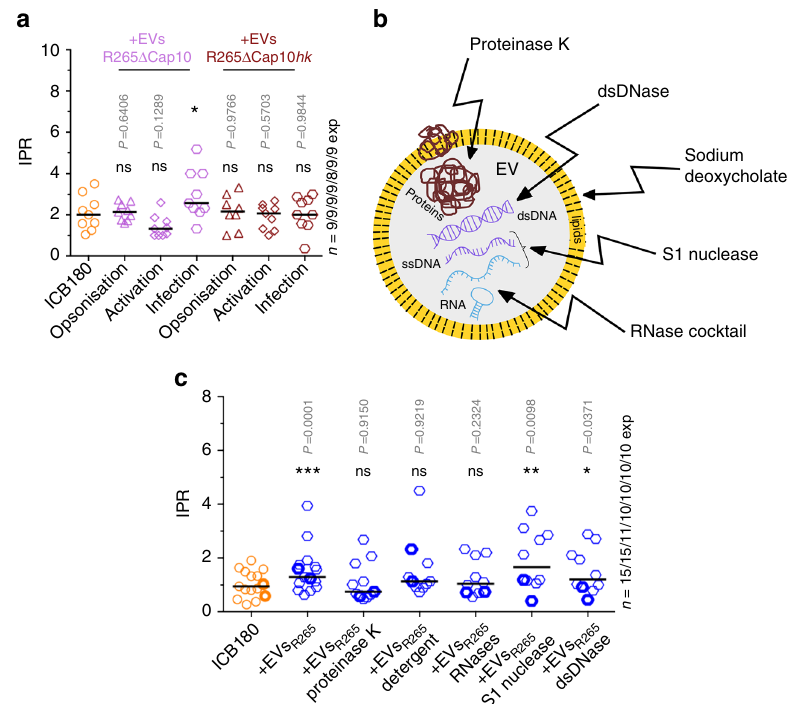
Fig. 4 EV proteins and RNA are necessary to increase survival of cryptococci inside macrophages. a IPRs of ICB180 growing alone (ICB180) and in the presence of 10 μ g of EVs isolated from acapsular strain R265 Δ Cap10 (EVs R265 Δ Cap10 ) or heat-inactivated EVs R265 Δ Cap10 (EVs R265 Δ Cap10 hk ) added at different stages of infection: during yeast opsonisation using PHS (opsonisation), J774 activation (activation) or during incubation with both macrophages and ICB180 yeast cells (infection; see also Fig. 3a). Data are presented as scattered dot plots with lines representing their medians. Data are representative of results from 8 to 9 independent experiments with 147 – 301 total number of yeasts counted for each sample. Wilcoxon paired t test where * ( P = 0.0117), signi fi cant difference; and ns ( P > 0.05), not signi fi cantly different. b Schematic drawing of the EV and treatments performed towards protein degradation via proteinase K, lipids degradation via sodium deoxycholate, double-stranded DNA (dsDNA) degradation via dsDNase, single-stranded DNA (ssDNA) and single-stranded regions of RNA degradation via S1 nuclease and further RNA degradation, including RNA duplexes, via RNase cocktail of RNase A and T1. c IPR values of ICB180 are increased in the presence of 10 μ g of EVs (or 50 μ g — symbols with thicker borders) isolated from R265 ( + EVs R265 ), EVs R265 treated with S1 nuclease ( + EVs R265 S1 nuclease) and EVs R265 treated with dsDNase ( + EVs R265 dsDNase) but not when EVs treated with proteinase K ( + EVs R265 proteinase K), sodium deoxycholate ( + EVs R265 detergent) or RNase cocktail ( + EVs R265 RNases) were used. Data are representative of results from 10 to 15 independent experiments with 1181 – 2691 total number of yeasts counted for each sample. Wilcoxon paired t test where * ( P ≤ 0.05), signi fi cant difference; ** ( P ≤ 0.01), signi fi cant difference, *** ( P ≤ 0.001), signi fi cant difference and ns ( P > 0.05), not signi fi cantly different